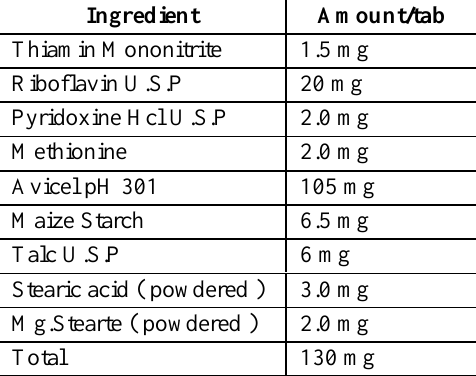
Table 2 : The formula of the